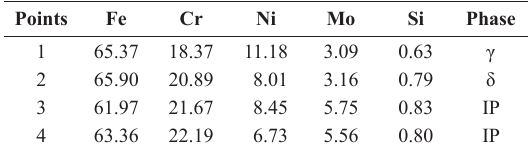
Table 5. Chemical composition of the points identified by EDS in Figure 4a (Wt%).